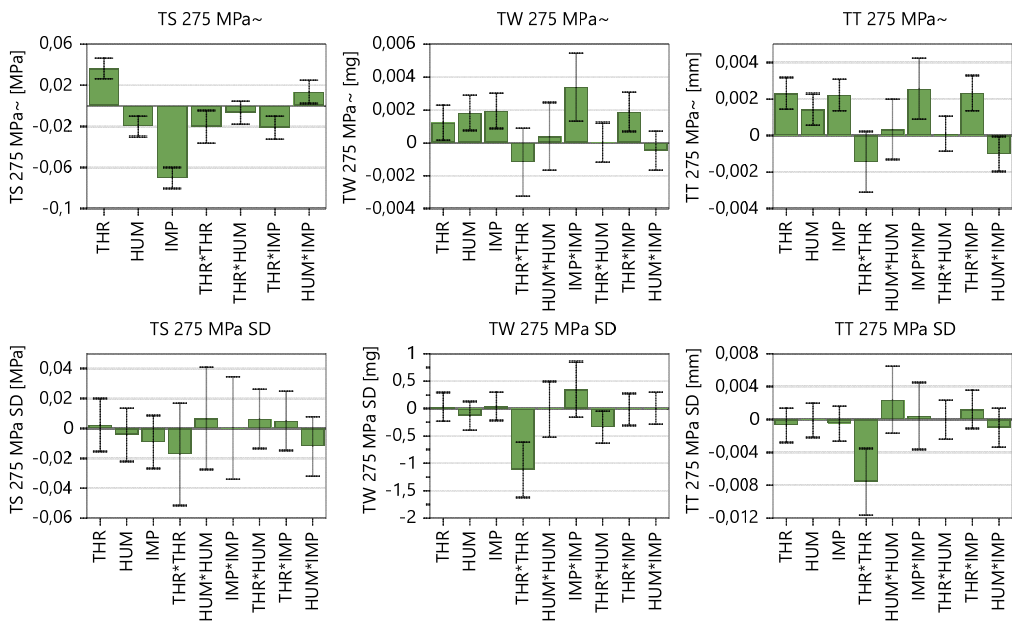
Figure 8. Model terms regarding tensile strength (TS), tablet weight (TW), tablet thickness (TT) and corresponding standard deviation. The 95% confidence interval is displayed as an error bar.